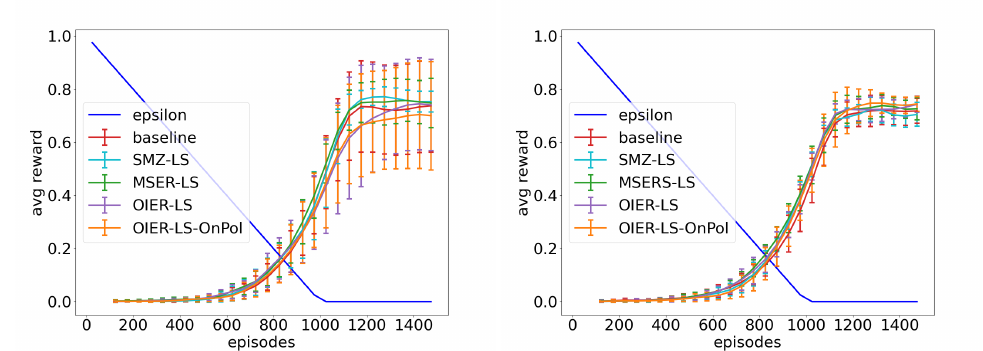
Figure A9. The results for the IER mode: LS and t expl = 1000. state encoding: VE. state encoding: CE.